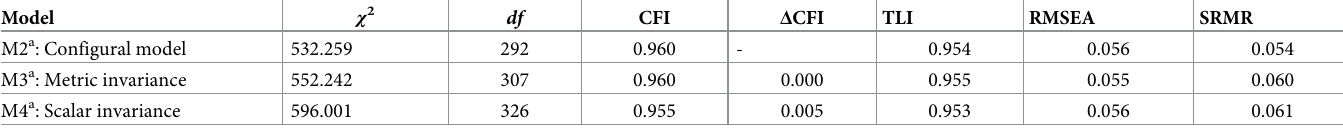
Table 3. Fit indices for measurement invariance tests of the model across